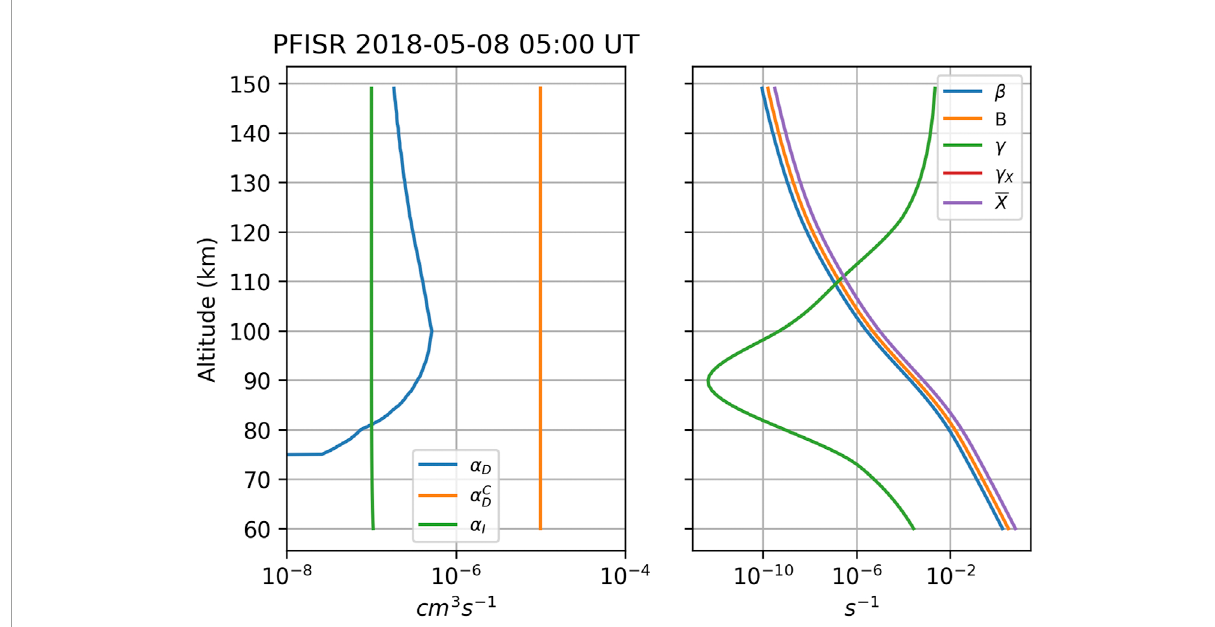
FIGURE 1 Altitude profiles of the coefficients used in Eq. 1. The left column shows the recombination rates with units of cm 3 s −1 and the right column shows other reaction rates which have units of s −1 . The profiles are shown from 60 to 150 km altitudes at the location of the Poker